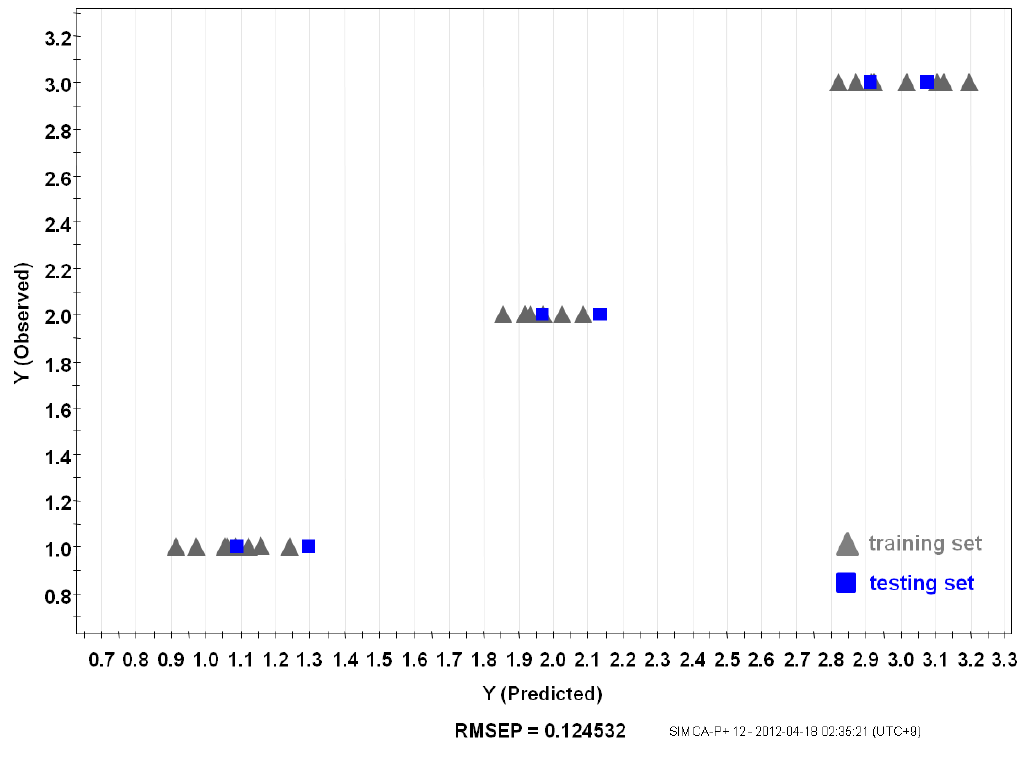
Figure 6. Relationship between observed and predicted Panax ginseng origin of PLS model. Training set (gray) and testing set